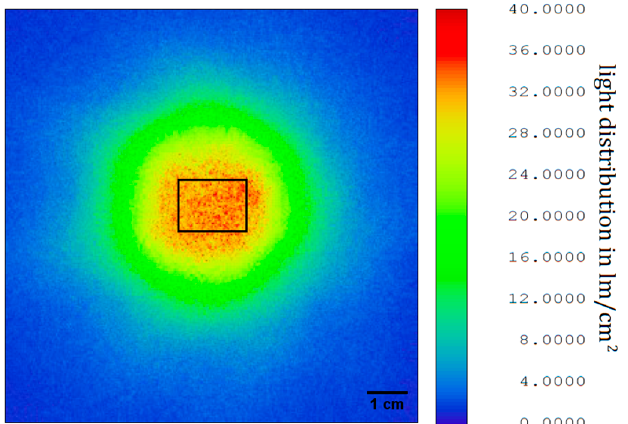
Figure 5. Light distribution at a distance of 45 cm from the illumination unit. The square shows the area of interest at this distance.